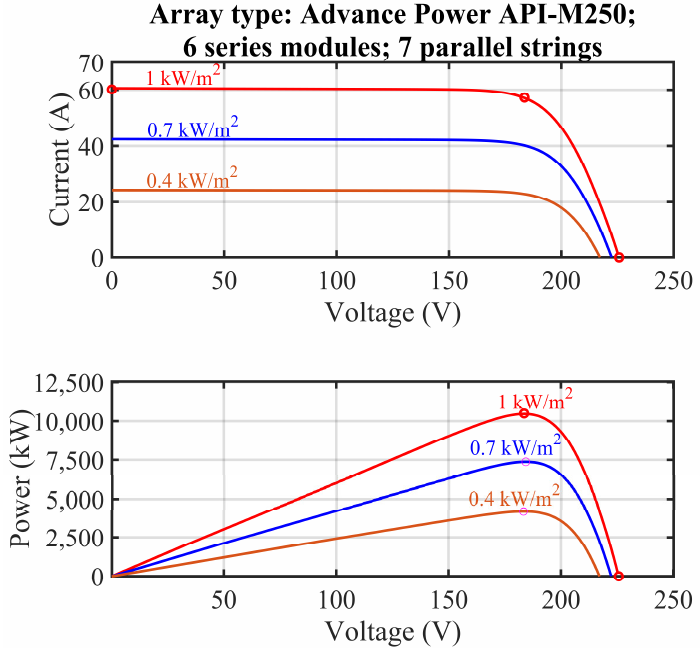
Figure 13. Relevant PV generator characteristics.